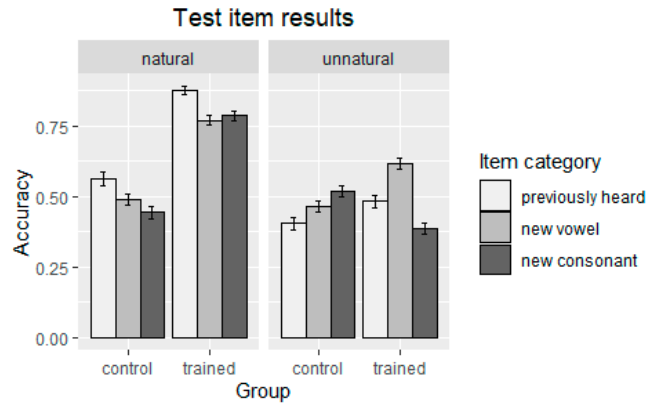
Figure 1. Accuracy of responses to test items.